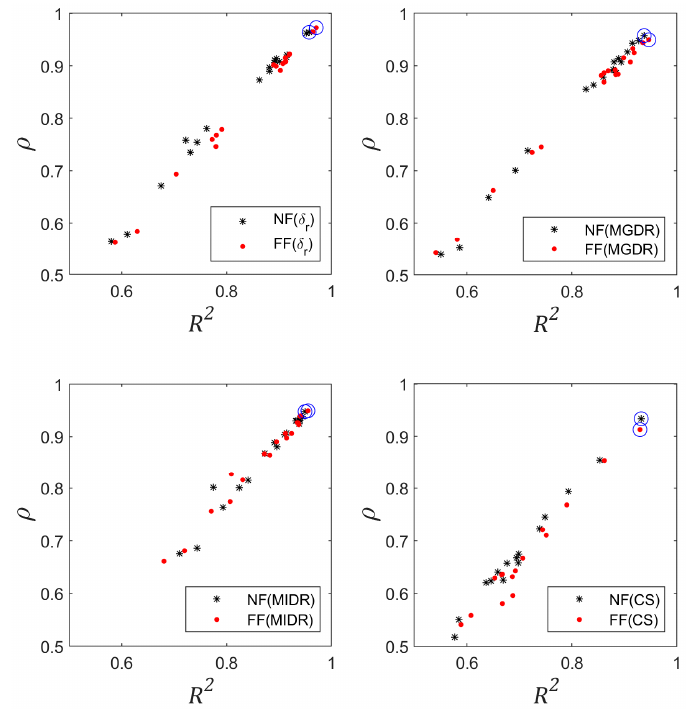
Figure 12. Comparison between R 2 and the Spearman coefficient ρ .